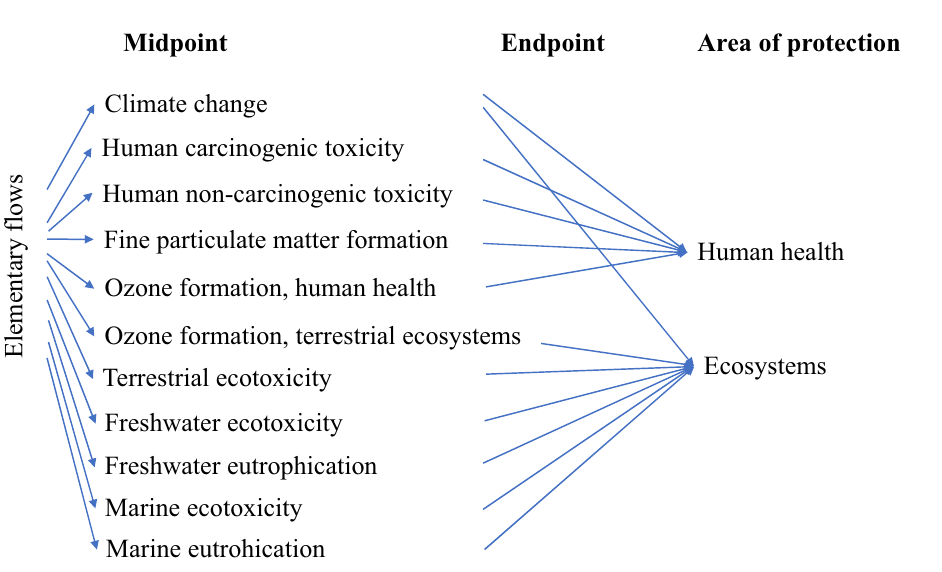
Figure 2. Graphic presentation of the link between the used midpoint and endpoint impact assessment categories ( modified from Huijbregts et al. 28